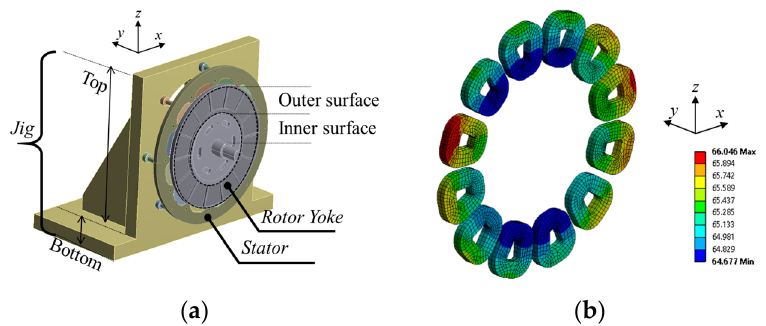
Figure 10. ( a ) Three dimensional analysis model; and ( b ) temperature distribution in the coils.